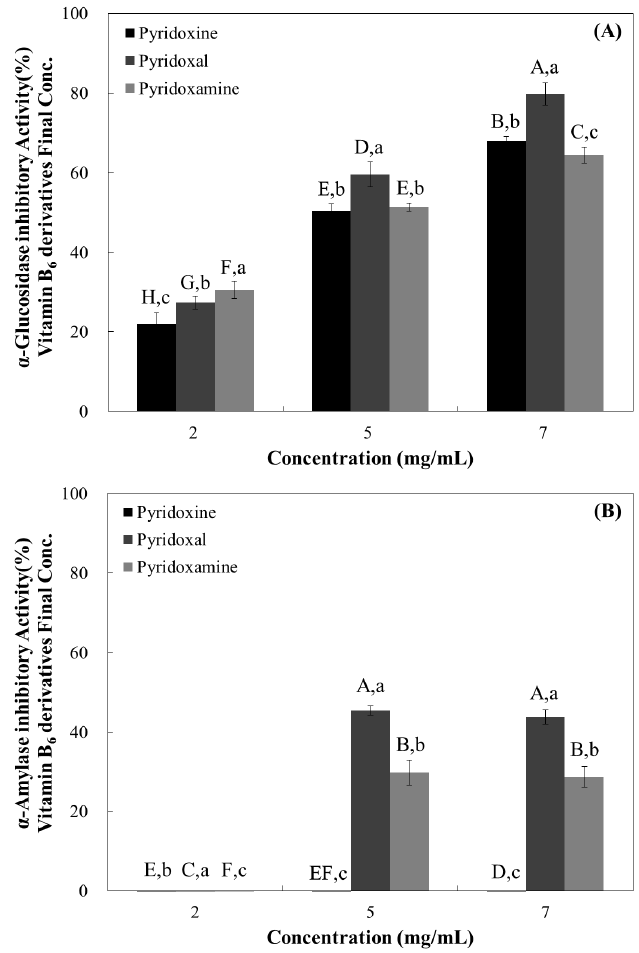
Figure 2. Dose-dependent changes in rat intestinal α -glucosidase ( A ) and porcine pancreatic α - amylase inhibitory activities ( B ) (% inhibition) of pyridoxine, pyridoxal, and pyridoxamine. The results are expressed as mean ± S.D. with three independent experiments in triplicate. Different corresponding letters indicate significant differences at p < 0.05 by Duncan’s test. The first letters in uppercase ( A–H ) indicate significant differences among all samples. The second letters in lowercase ( a–c ) are different among types of vitamin within the same concentration. Table 1. The half maximal inhibitory concentration (IC 50 ) of pyridoxine and its derivatives on rat intestinal α -glucosidase, sucrase, maltase, glucoamylase, and porcine pancreatic α -amylase activities. IC 50 (mg/mL) Rat intestinal α - Porcine Pancreatic Rat Intestinal IC 50 Glucosidase α -Amylase SUCRASE